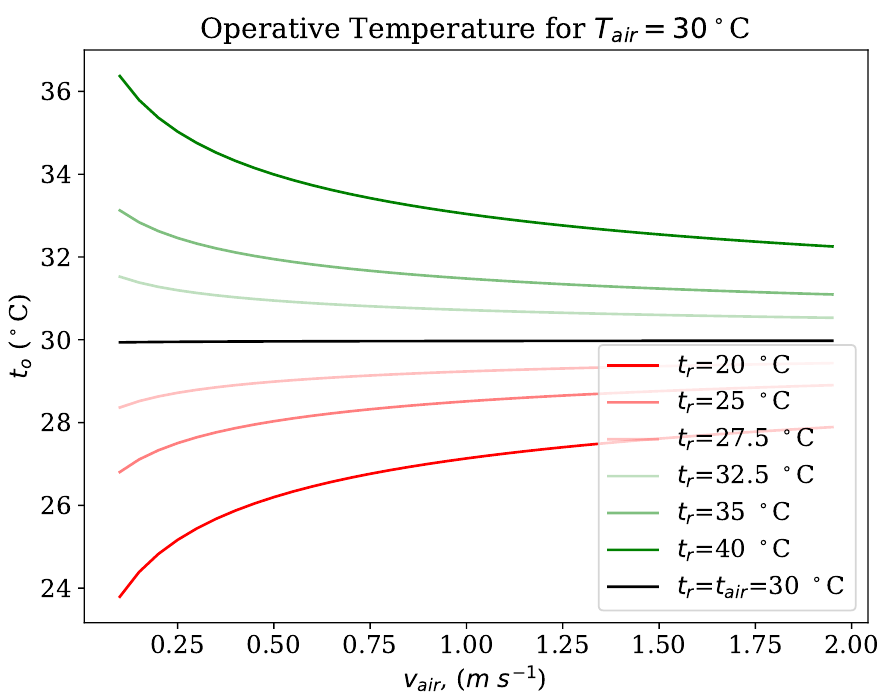
Figure 8. Demonstrating two regimes of operative temperature versus air speed calculated using Equation (1); green represents a regime where t r > t a , which results in an intuitive relationship where the operative temperature decreases as air speed increases; red represents a regime where t r < t a , which results in operative temperature increasing as air speed increases. This is counterintuitive since an increase in air speed results in more cooling capacity relative to a human body; however, an increasing operative temperature implies warmer